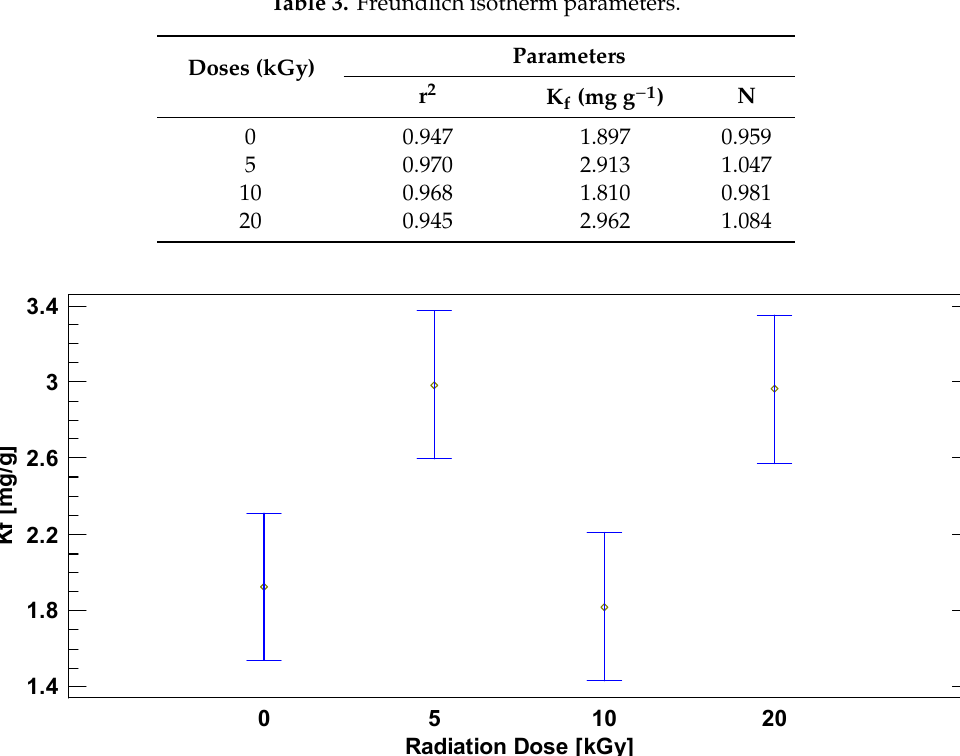
Table 3. Freundlich isotherm parameters.